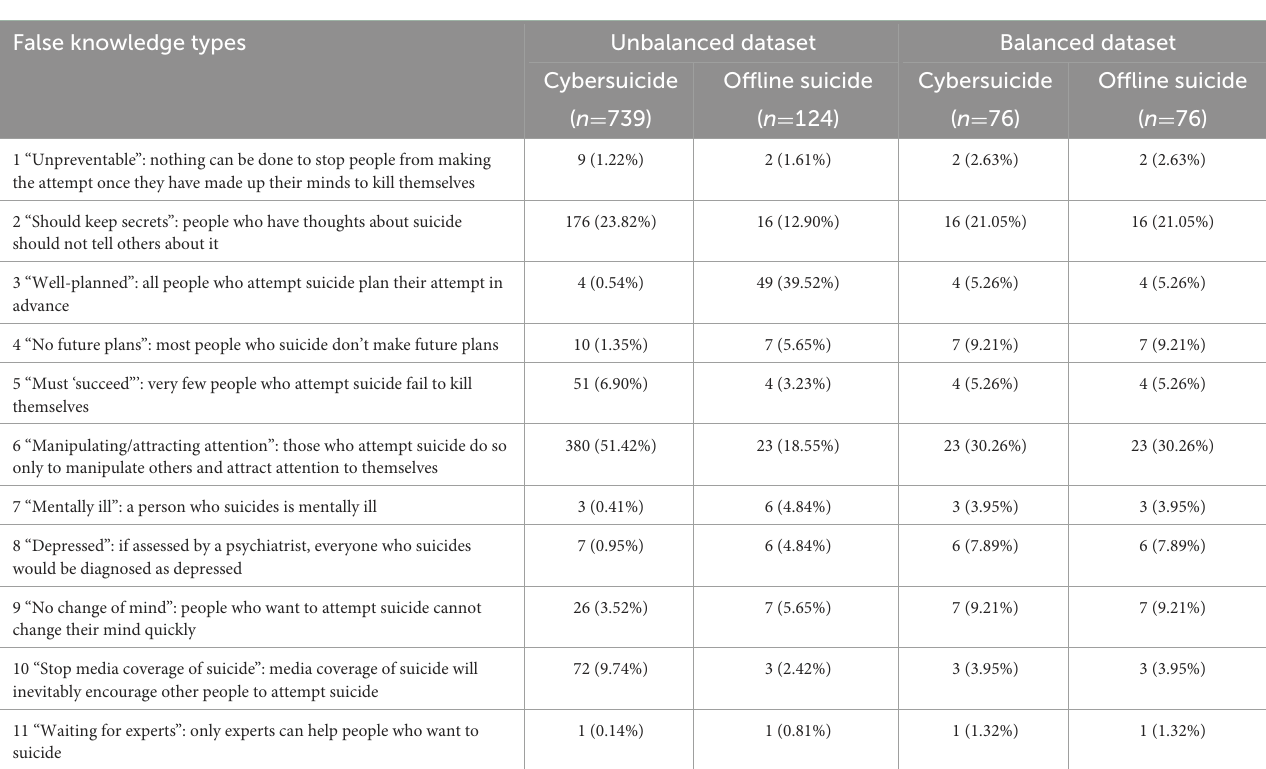
TABLE 1 Results of human coding for suicide literacy: n =